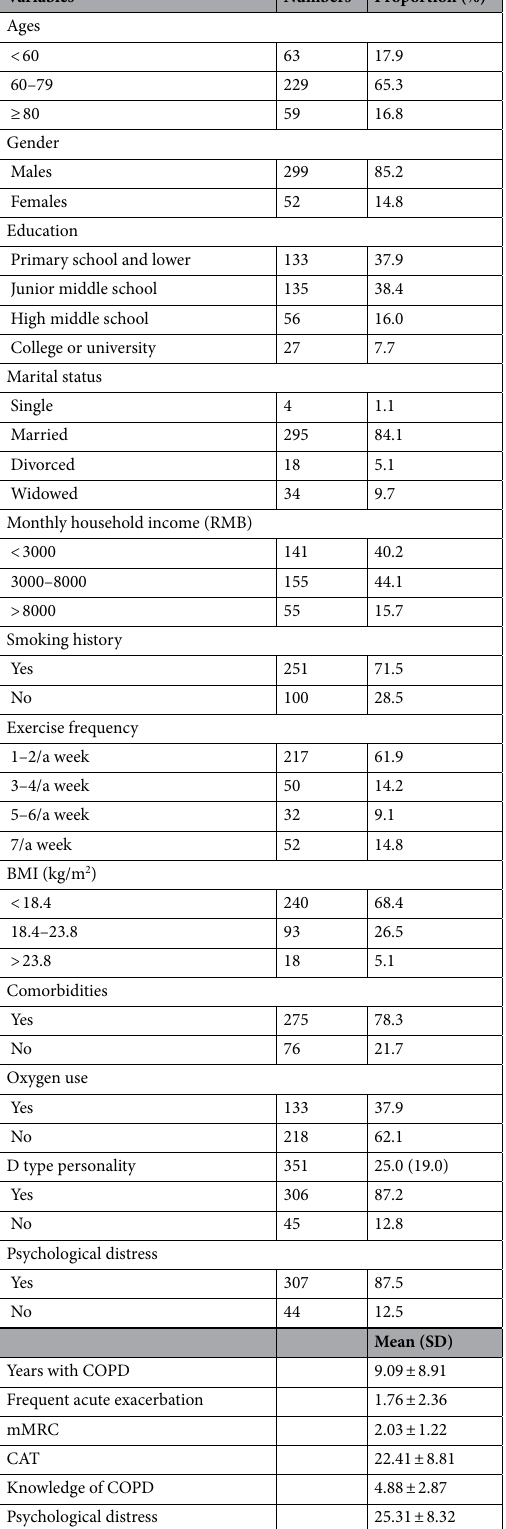
Table 1. Variables summary of COPD patients (n = 351). Mean, median value; SD, standard deviation; mMRC, modified Medical Research Council Dyspnea scale; CAT, COPD assessment test; BMI, body mass